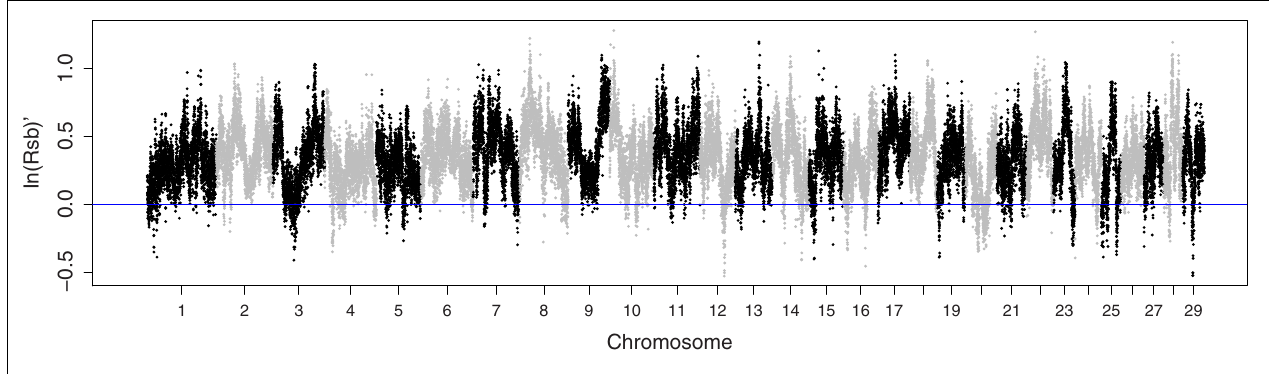
FIGURE 2 | Manhattan plot of extended haplotype homozygosity contrasting Line 1 Hereford cattle with a broader sample of the Hereford breed.